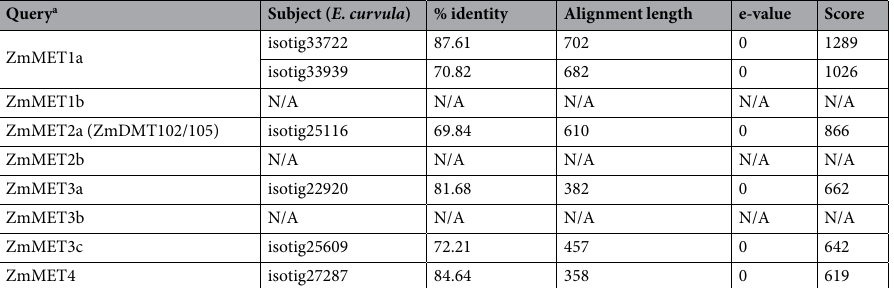
Table 2. Members of the DNA methyltransferase family queried against the Eragrostis curvula protein prediction databases. a Query names as described by 19 . They renamed ZmDMT102 as ZmMET2a; therefore, isotig25117 is the ortholog of ZmDMT102.